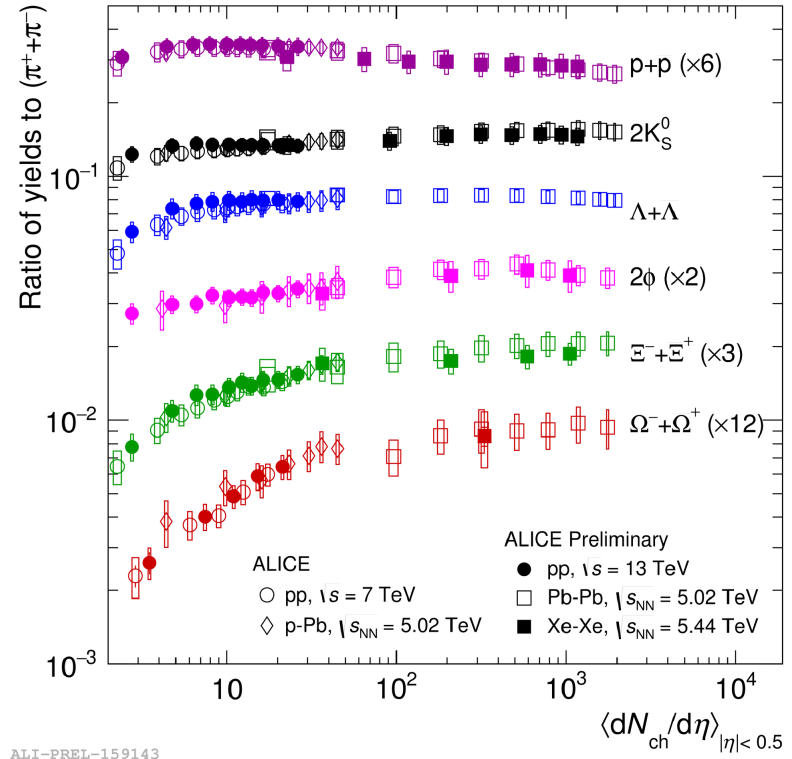
Figure 4. Proton, K 0 s , Λ , Ξ , Ω and φ over π ratios as a function of charged multiplicity for different collision systems. Figure taken from